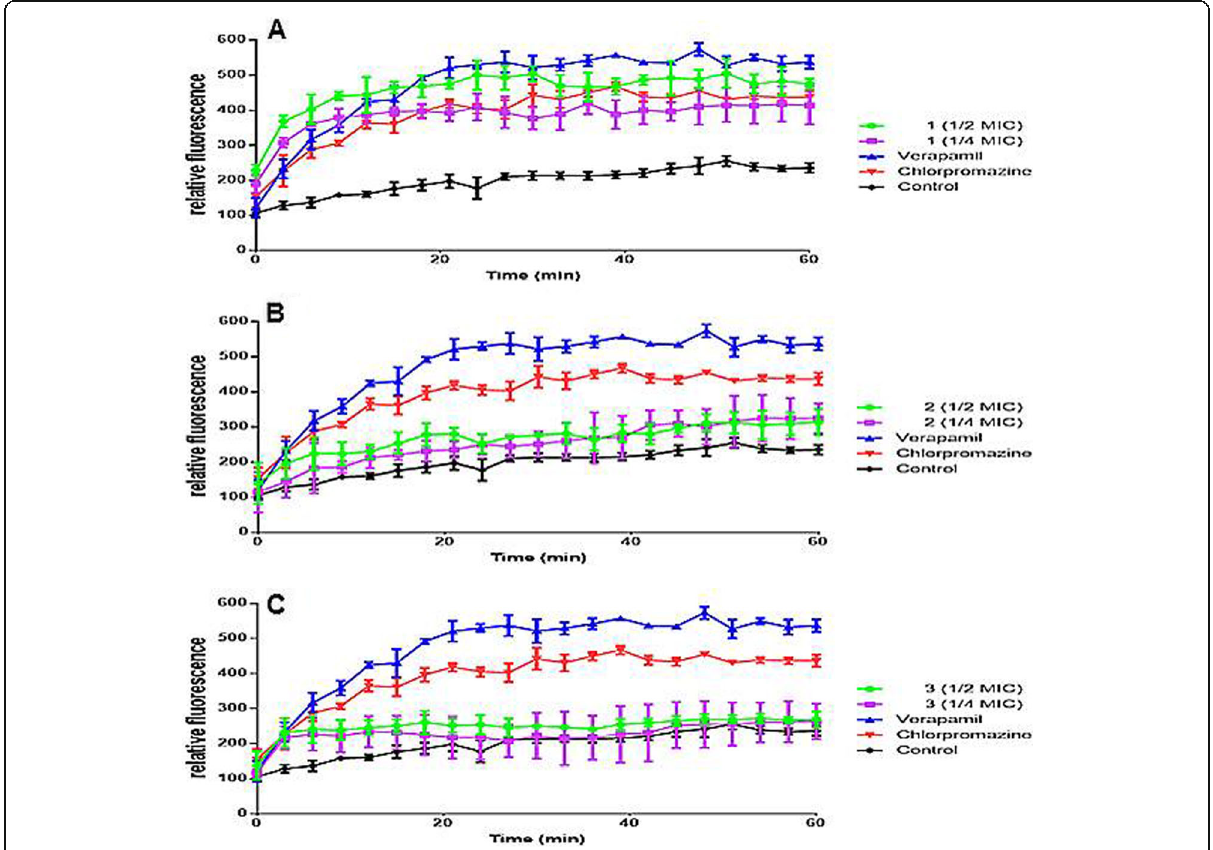
Fig. 6 Efflux pump inhibition effect of compounds 1 – 3 (A-C) in P.